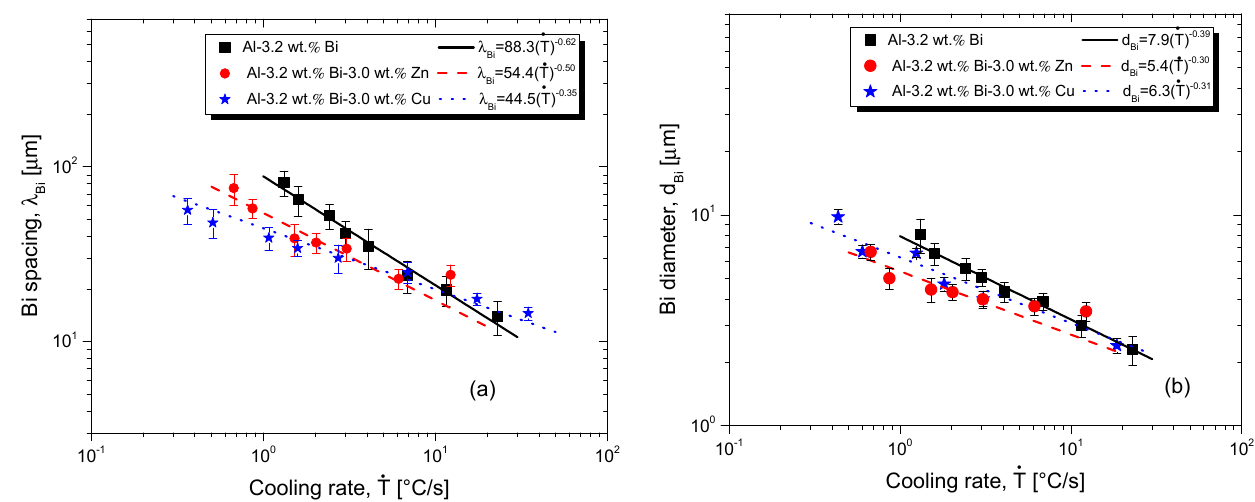
Figure 4. ( a ) Spacing between Bi droplets and ( b ) Bi diameter varying with cooling rate for the Al-3.2 wt.% Bi (squares symbols), Al-3.2 wt.% Bi-3.0 wt.% Zn (circles symbols), and Al-3.2 wt.% Bi-3.0 wt.% Cu (stars symbols) alloys.